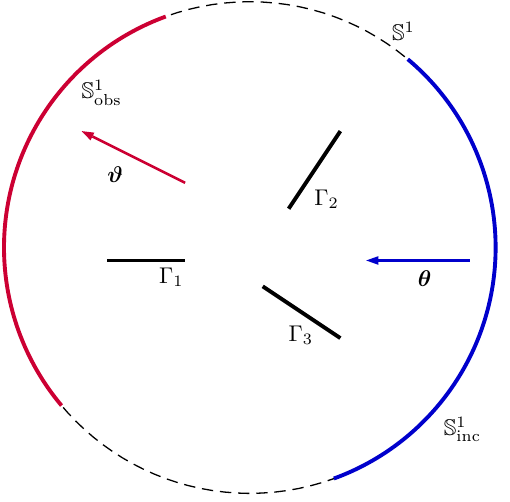
, and perfectly obs